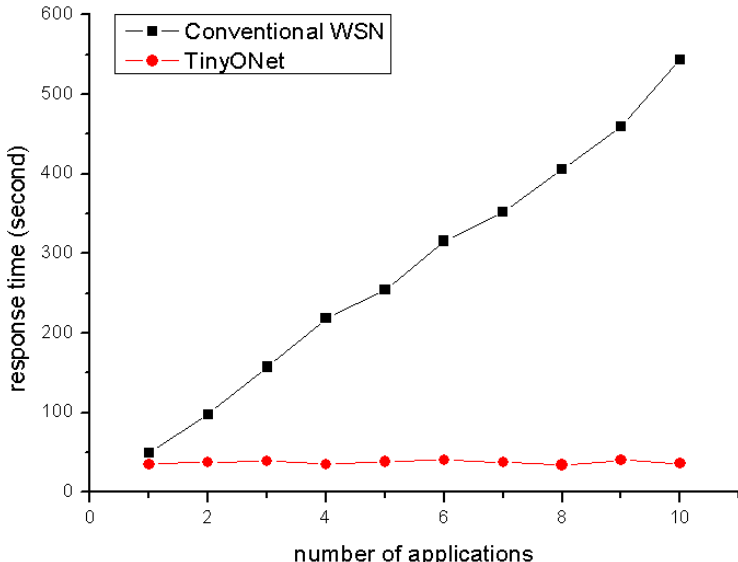
Figure 11. Response time as increasing the number of